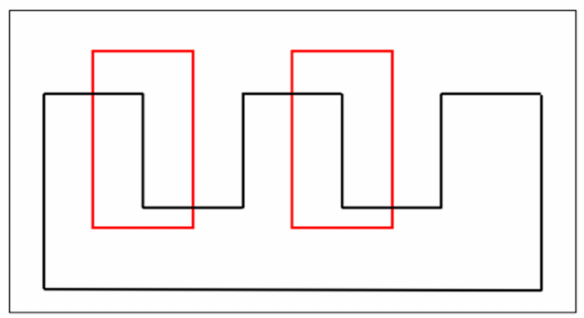
Figure 2. Relationship between receptive field and